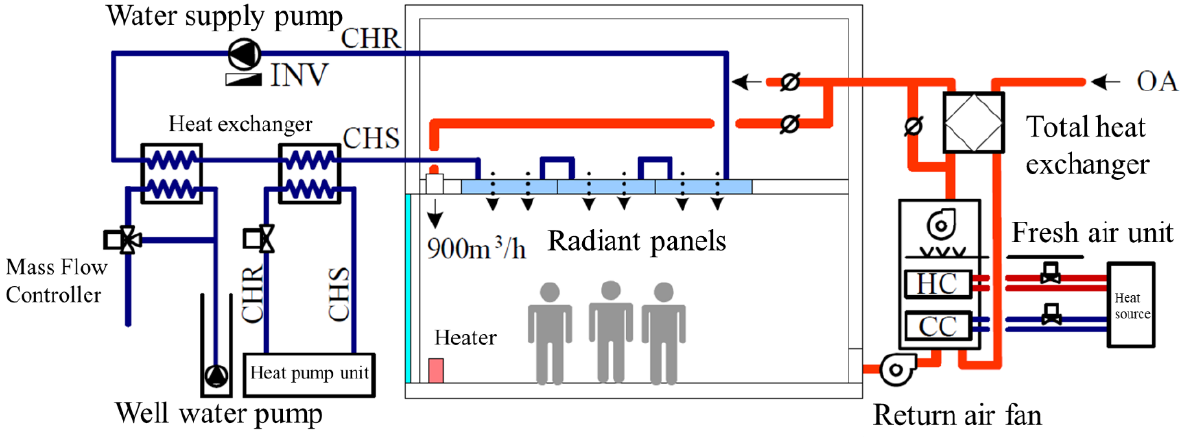
Figure 4. Schematic diagram of radiant air conditioning system.